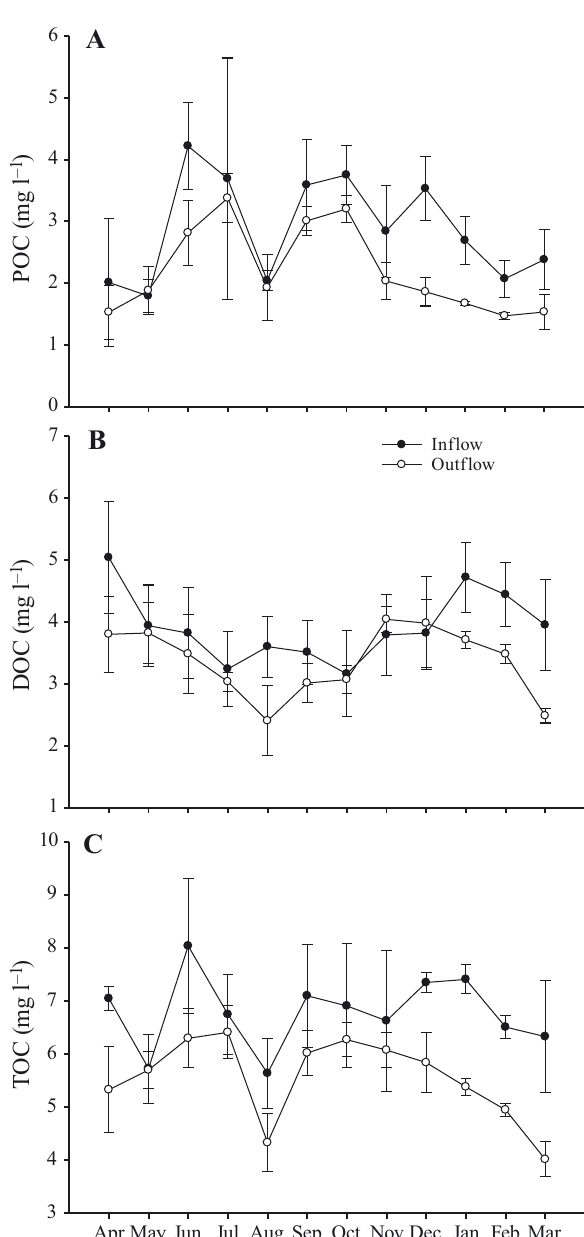
Fig. 1. Variations in (A) particulate organic carbon (POC), (B) dissolved organic carbon (DOC) and (C) total organic carbon (TOC) of inflow and outflow water from polyculture seawater ponds without feeding. Data are means ±